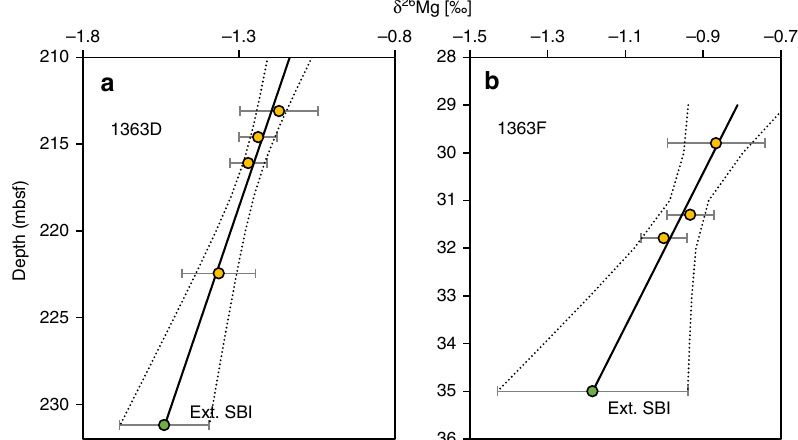
Fig. 6 Extrapolation of pore-water data. The δ 26 Mg values in pore water are linearly extrapolated to the sediment-basement interface (SBI) depth. a Hole U1363D and b Hole U1363F. Pore-water data are shown in yellow. Extrapolated-SBI data are shown in green. Error bars are 2